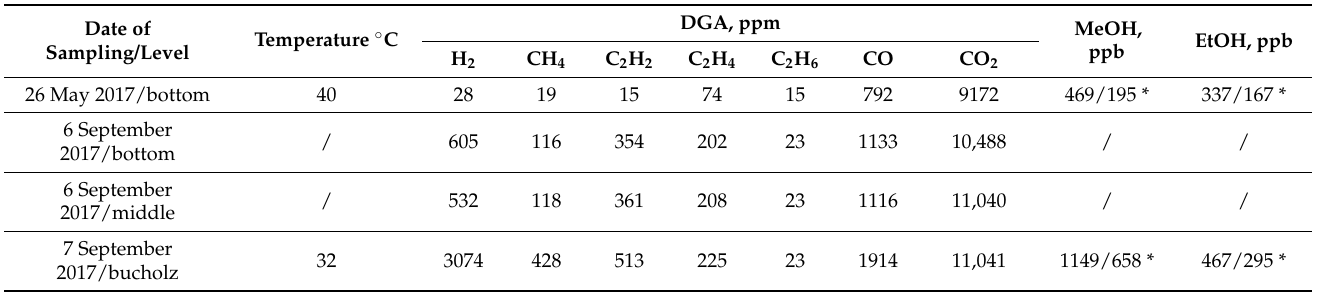
Table 8. Case 1—Dissolved gases and methanol and ethanol analysis before (26 May 2017) and after